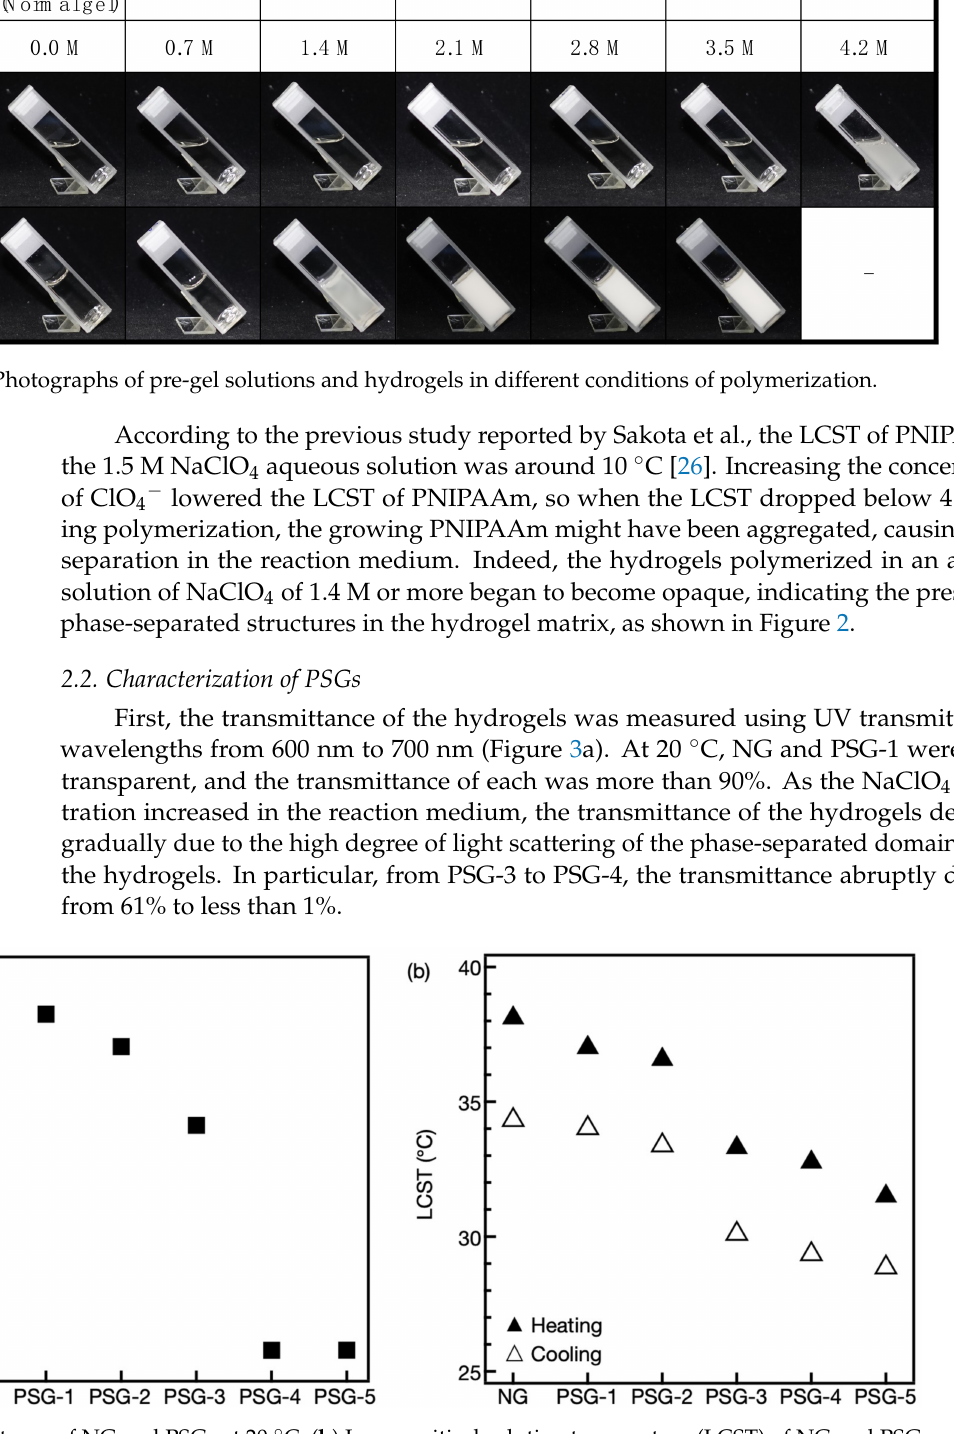
Figure 3. ( a ) Transmittance of NG and PSGs at 20 ◦ C. ( b ) Lower critical solution temperature (LCST) of NG and PSGs upon heating and cooling observed by differential scanning calorimetry (DSC) (Heating, filled triangle; Cooling, open